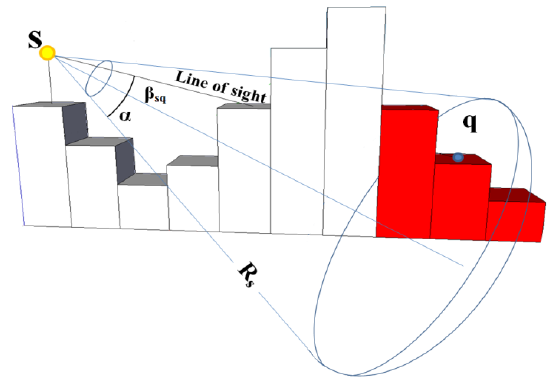
Figure 2. 3D coverage estimation in raster model (red pixels are not covered by the sensor S)